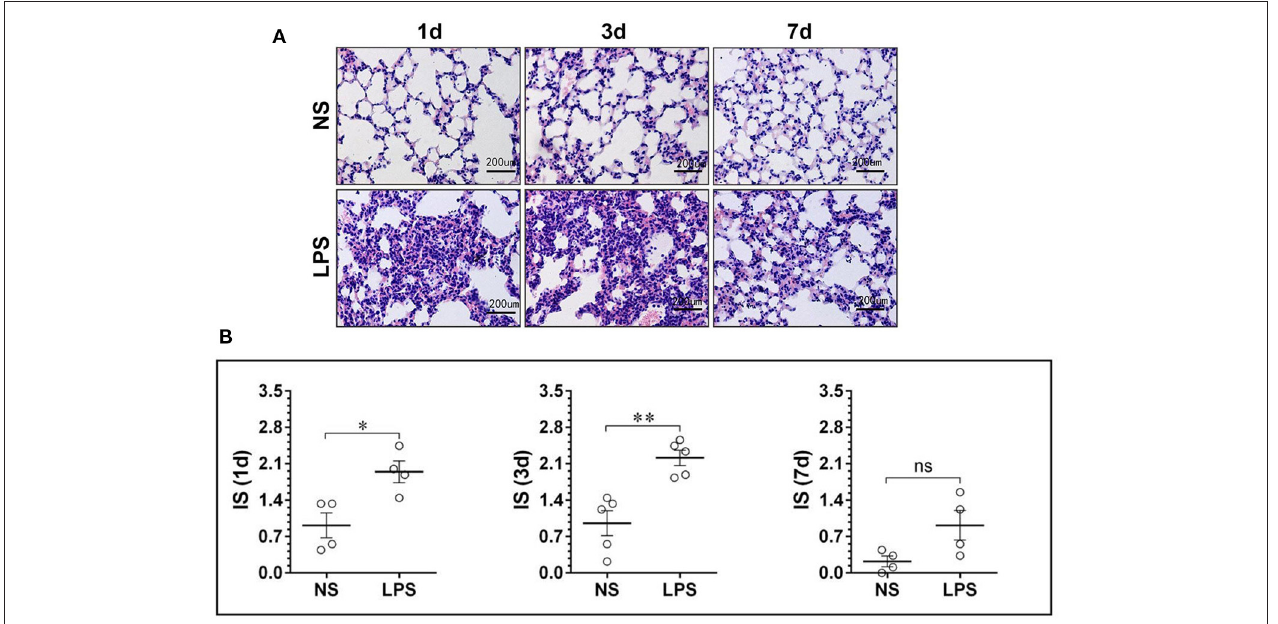
FIGURE 1 | LPS-induced massive leukocyte infiltration and alveolar structural damage. (A) H&E staining lung tissue sections showed alveolar edema and swelled alveolar epithelium under stimulation of LPS. (B) The inflammation score of the NS and LPS groups at different time points. LPS, lipopolysaccharide; NS, normal saline; HE, hematoxylin and eosin; IS, inflammation score. Scale bars correspond to 50 µ m in the micrographs. * p < 0.05, ** p < 0.01. Statistical results were an average of five animals in each